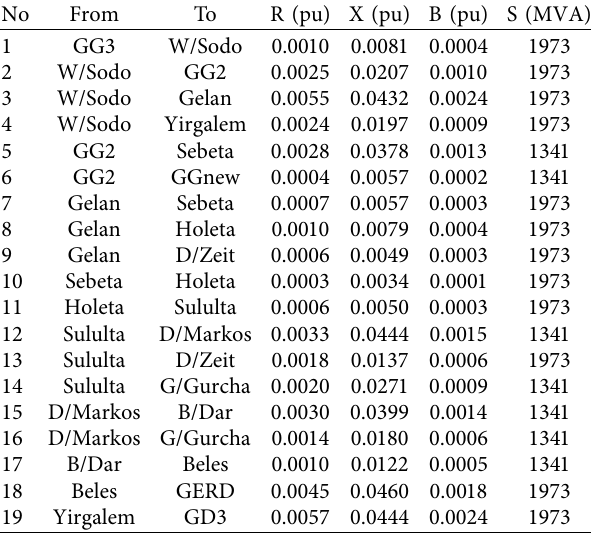
Table 2: Transmission line parameters of 400 kV system.